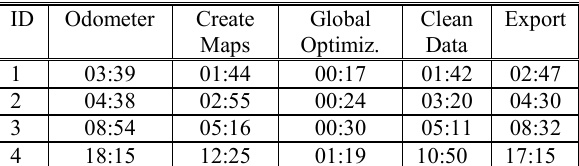
Table 3: Particular of the processing